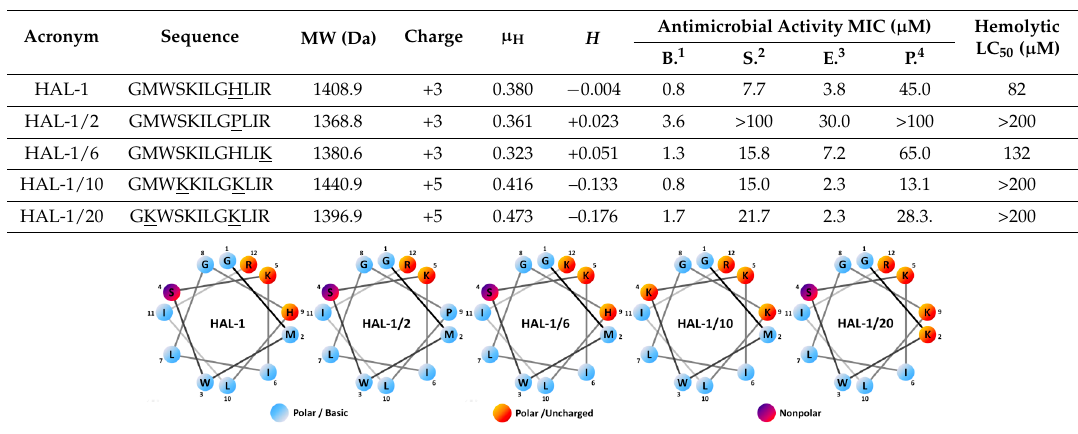
Table 1. Amino acid sequences, physico-chemical and biological properties ( µ H is the hydrophobic moment, and H represents the mean hydrophobicity, calculated according to [27]), of the studied antibacterial HAL-1 peptides. Data were taken from ref. [19]. Point mutations with respect to the natural HAL-1 peptide are underlined. The Schiffer − Edmundson wheel projection of the HAL-1 and its analogs is depicted below the table.